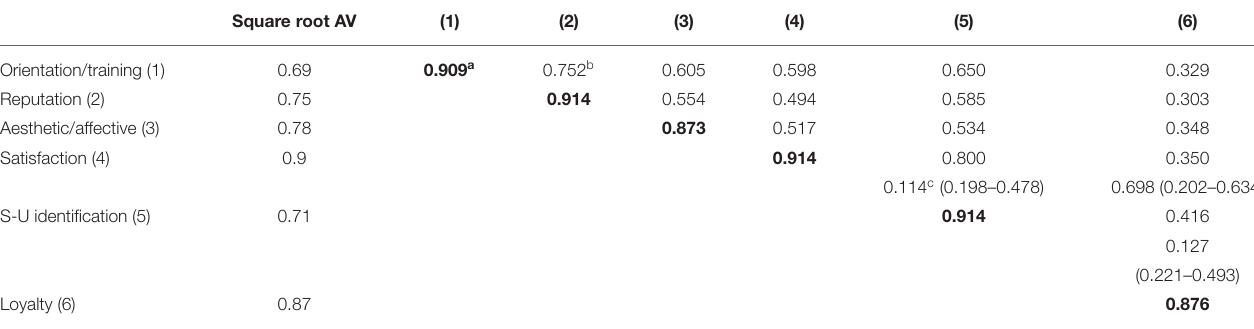
TABLE 4 | Correlation matrix and discriminant validity.